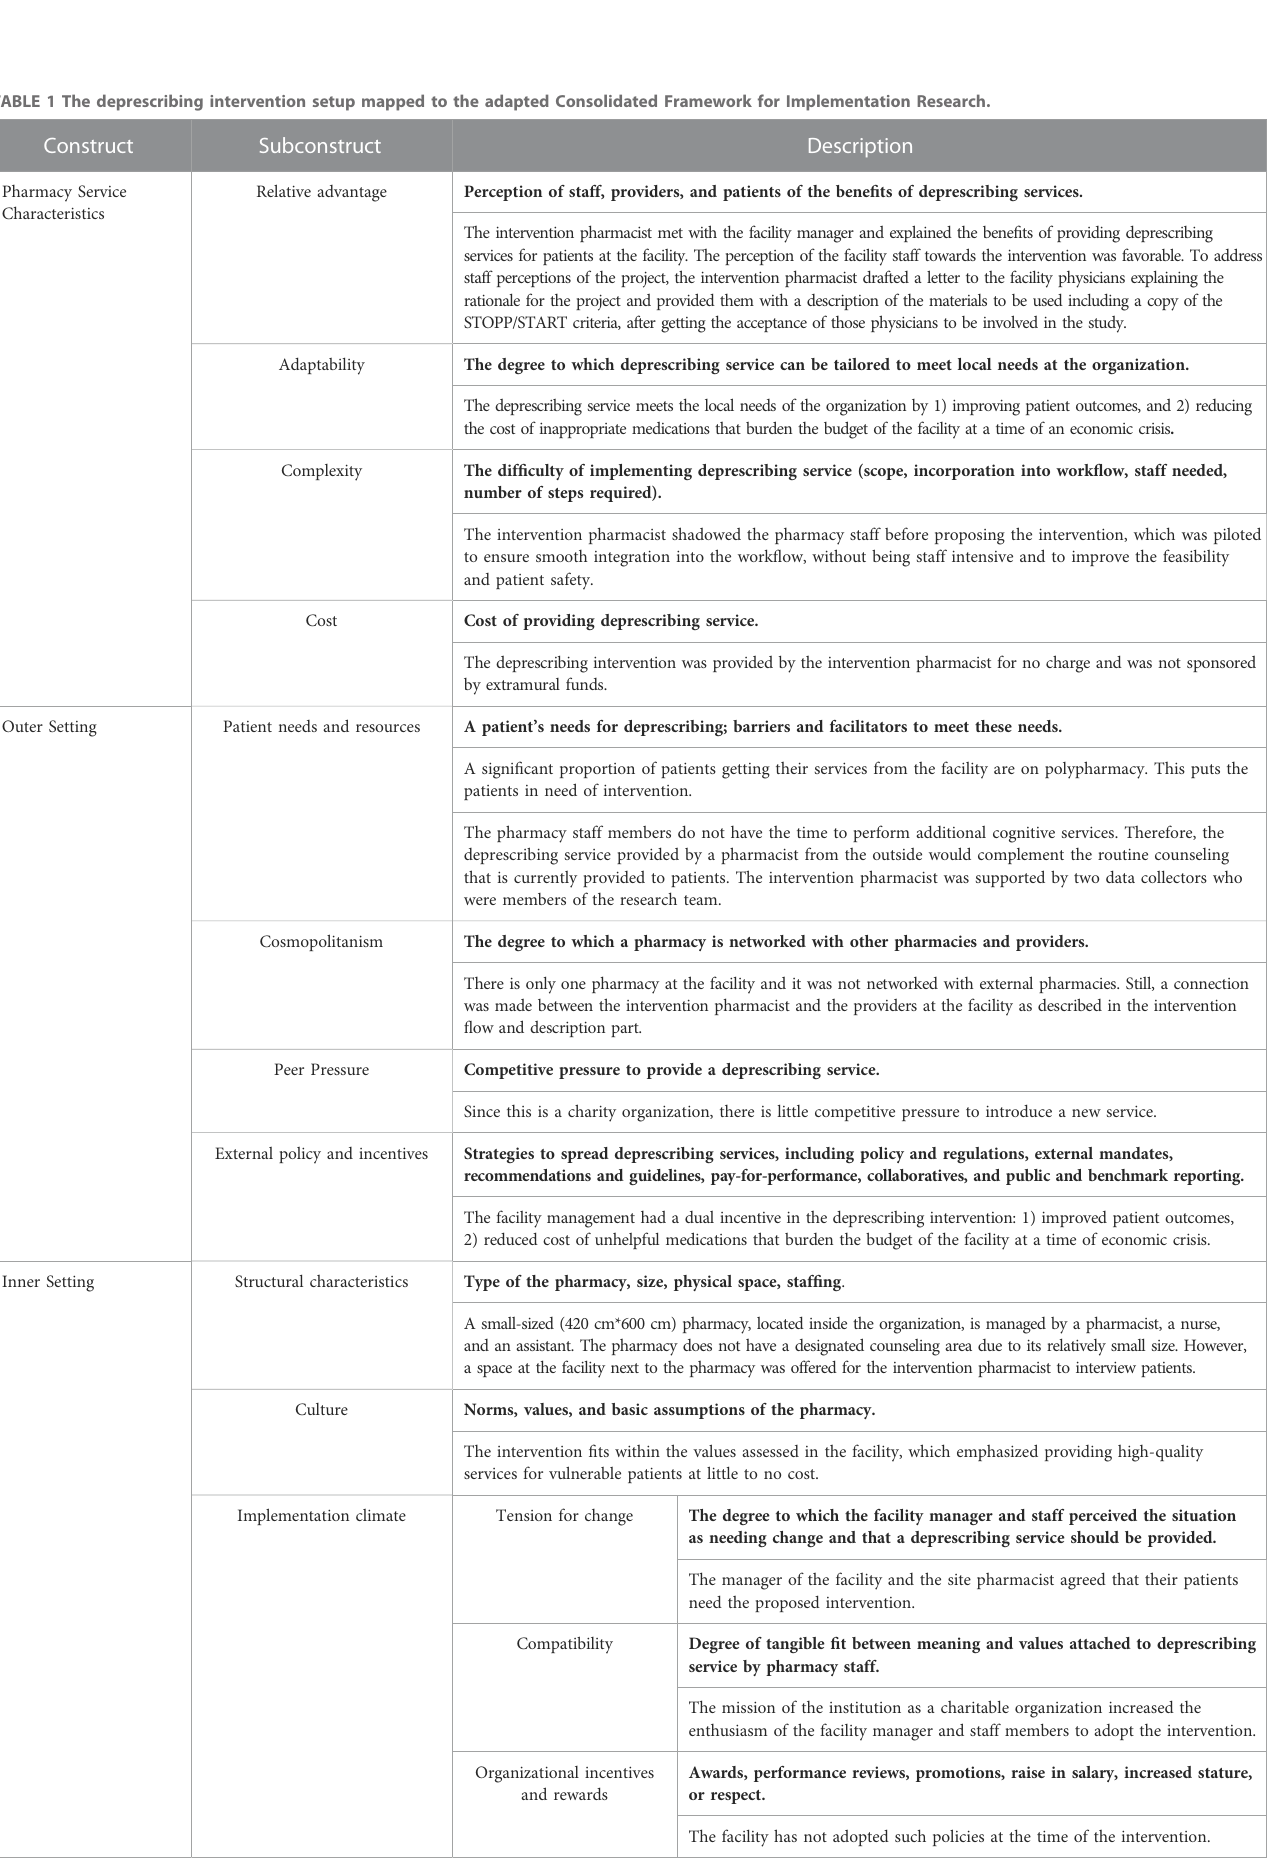
TABLE 1 The deprescribing intervention setup mapped to the adapted Consolidated Framework for Implementation Research.